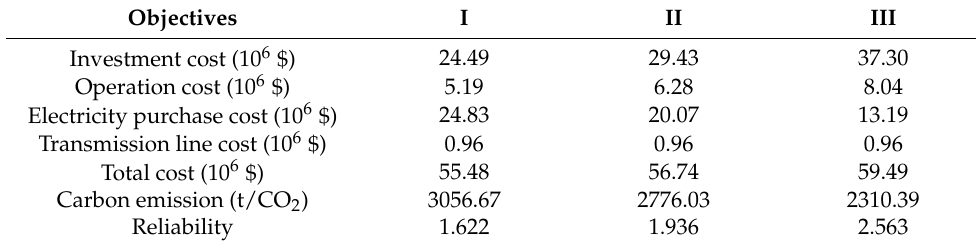
Table 5. The various indicators in the model under different